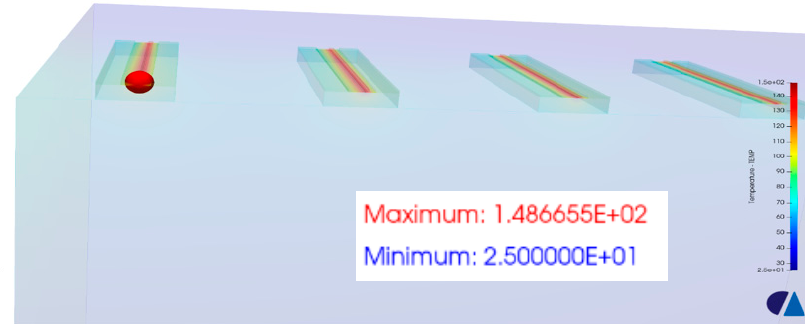
Figure 18. Finite Element Simulation.